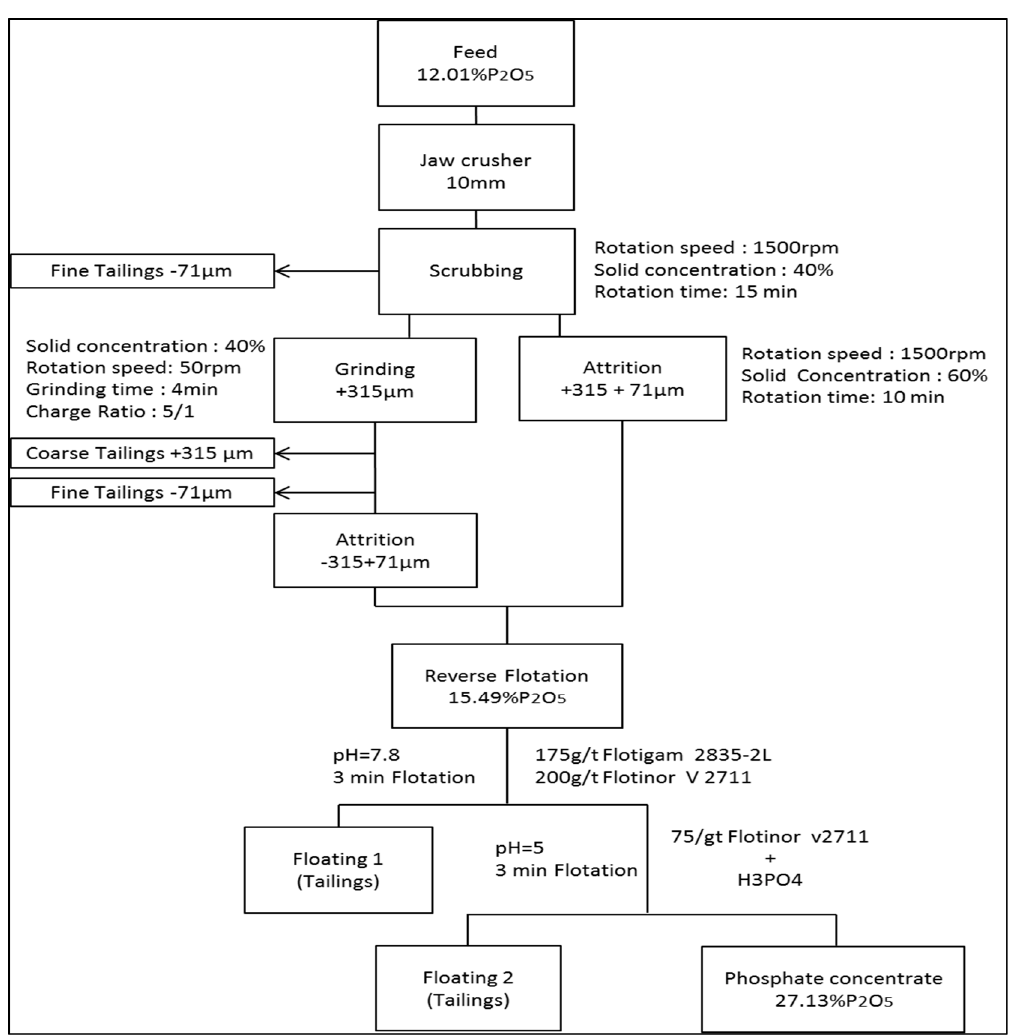
Figure 4. Proposed flow sheet for the valorization of the studied low ‐ grade phosphates.